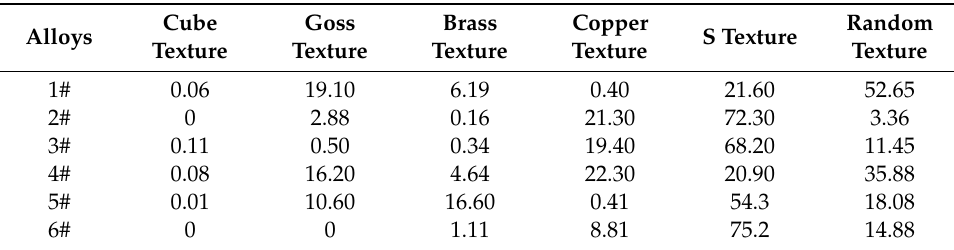
Table 2. Texture components of cold rolled alloys